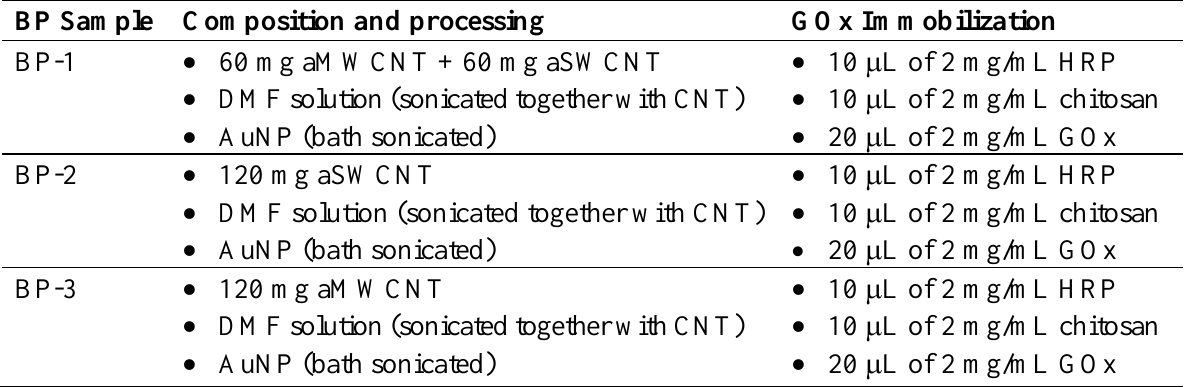
Table 1. Buckypaper sample description and composition of electrodes for glucose